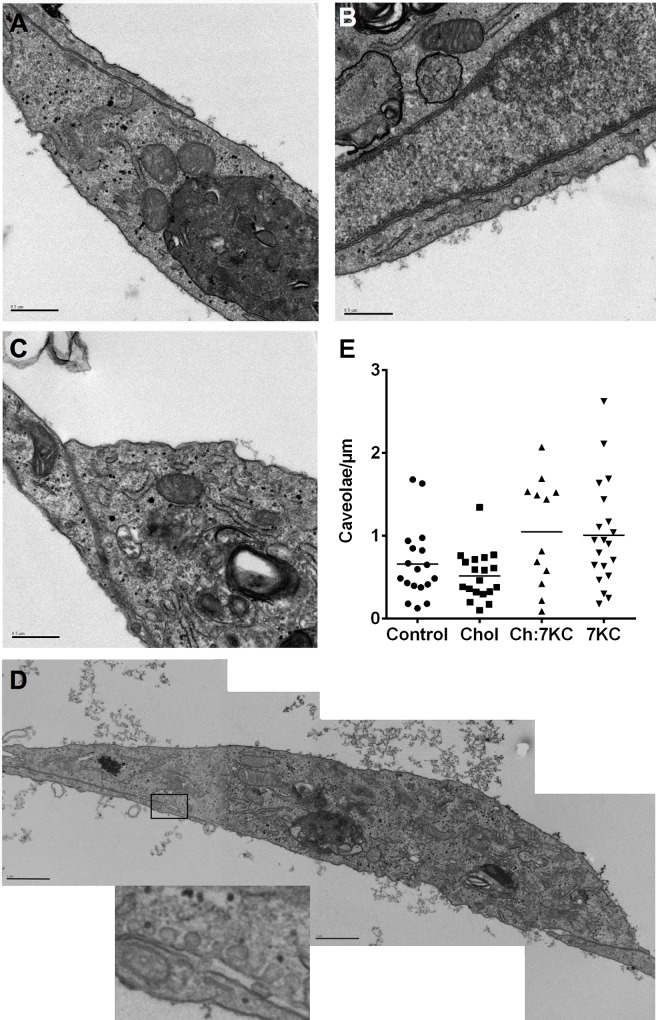
Caveolae quantification in control and sterol-enriched BAEC.BAEC were enriched with 40 μM Chol, 20 μM 7KC or a mixture of both 20 μM Chol and 20 μM 7KC (Ch:7KC). Cells were fixed and embedded in Spur resin, processed for TEM, and imaged. The images were connected using the plug-in Mosaic J in Image J. Representative TEM images of (A) control, (B) Chol, (C) Ch:7KC, and (D) 7KC-enriched cells. In (D), images were merged and a zoomed region is shown with caveolae visible in the membrane. Images are representative of >20 cells per condition. Scale bar = 0.5 μm (A-C) and 1 μm (D). (E) Caveolae was quantified along the plasma membrane to obtain the number of caveolae/μm of cell perimeter. Each symbol represents one cell and several images. Data were from 5 independent experiments. Horizontal lines indicate means. No significant difference was observed between control cells and sterol enriched cells (tested with one-way ANOVA).